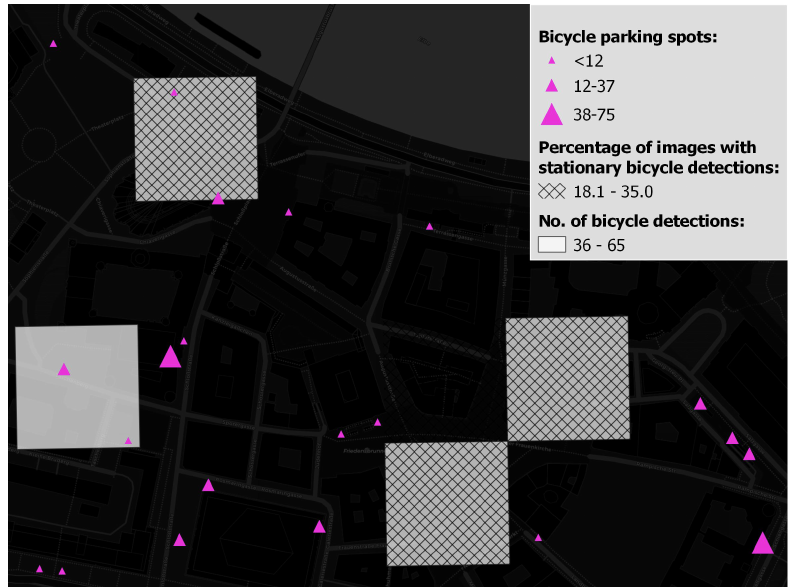
Figure 13. Example of visual analysis of bicycle parking capacity in Dresden by overlapping 100 × 100 m grid cells of the N PB (gray) and P PB (hashed) layers in QGIS (version